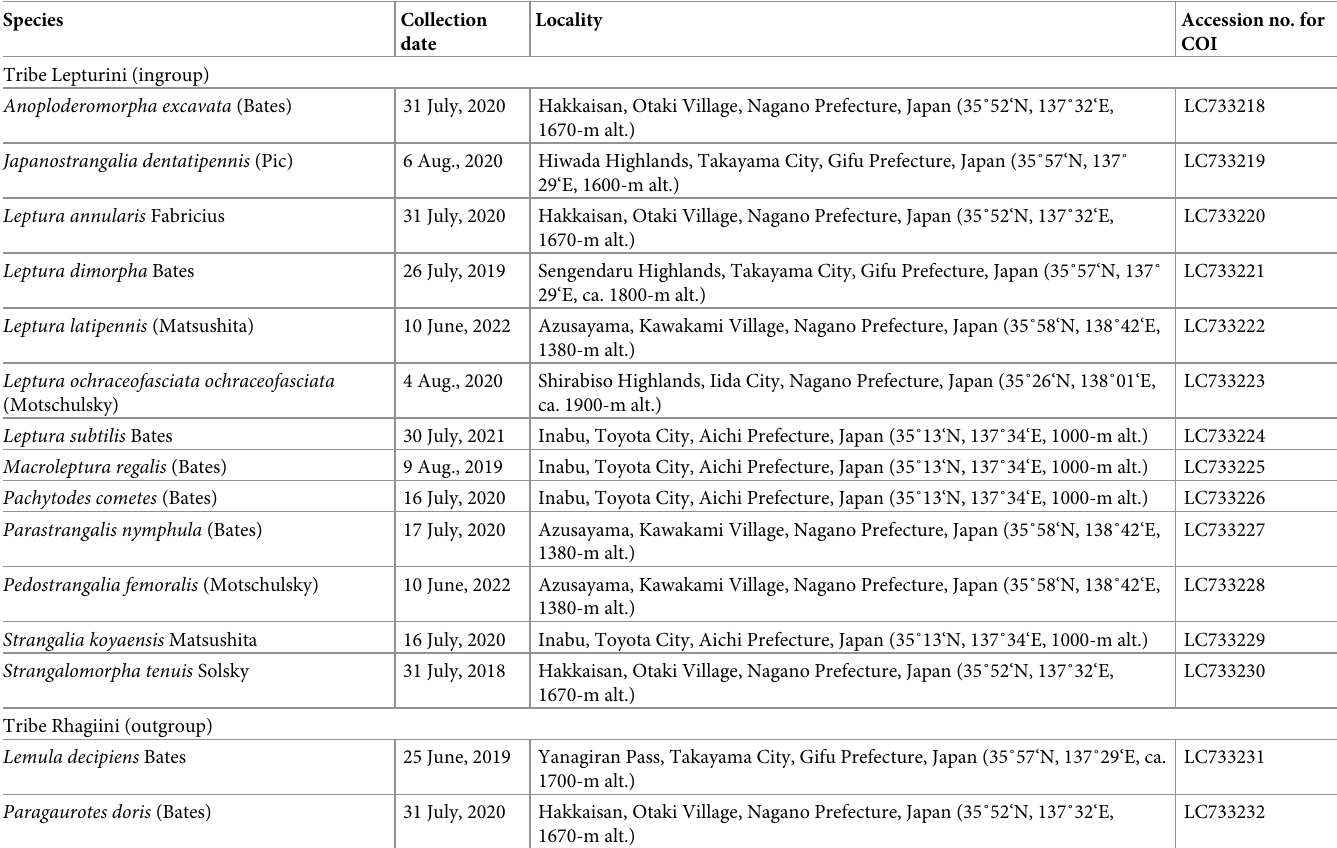
Table 2. Samples of adult lepturines used for larval